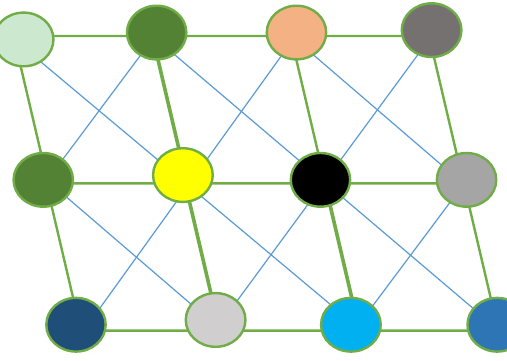
Figure 9. Clique for the L(3,1) coloring.